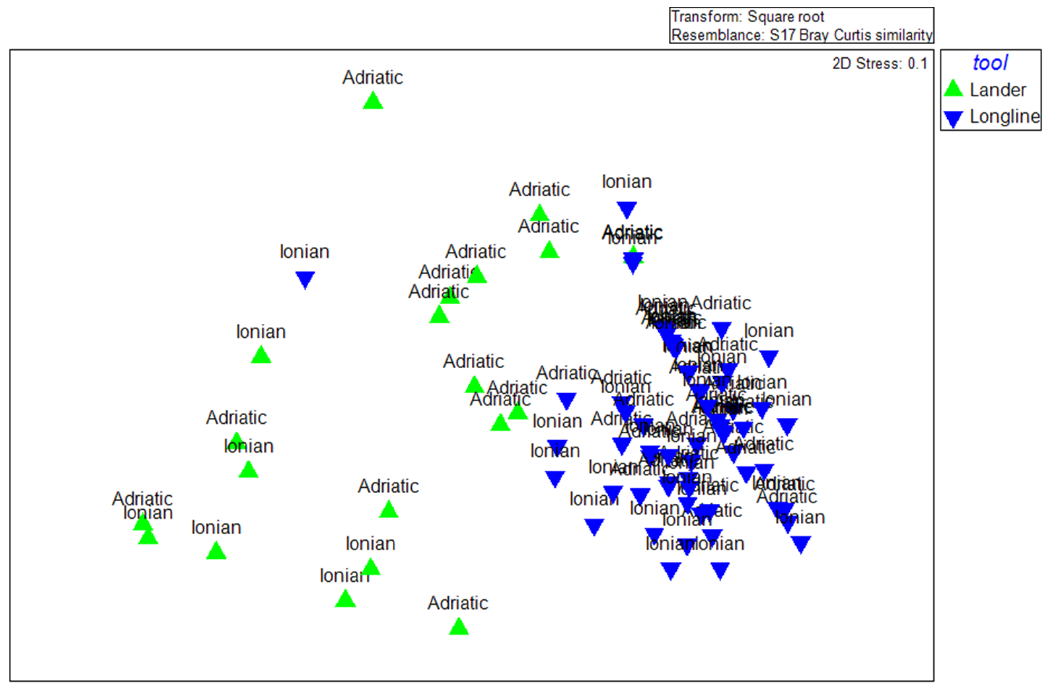
Figure 3. Non-metric multidimensional scaling (nMDS) plot of the abundance distinguishing among the areas and tools. Table 4. Results of a permutational analysis of variance investigating the differences among the geographic areas and tools examined in this study, based on Bray–Curtis dissimilarity matrices of abundance indices of cartilaginous fish species. The table gives the degrees of freedom (df), the sums of squares (S), the mean squares (MS), the values of the pseudo-F statistics, the p -values, and the number of permutations